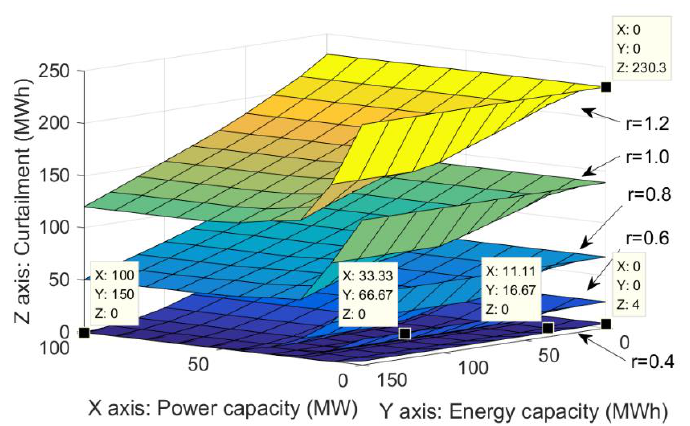
Figure 8. Comparison of optimal value functions with different renewable-energy penetration levels.